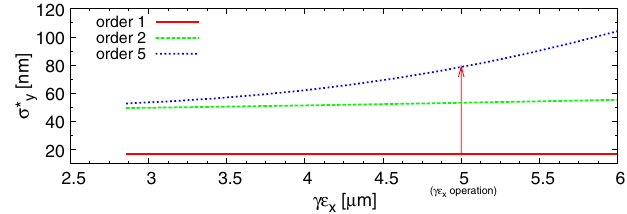
FIG. 3 (color online). Plot of σ (cid:1) y as a function of γϵ x for the ATF2 ultralow β (cid:1) lattice. The red curve represents the vertical IP beam size considering up to the quadrupole components, the green dashed curve includes the sextupole components, and the blue dot curve takes into account all of the multipoles up to the dodecapole